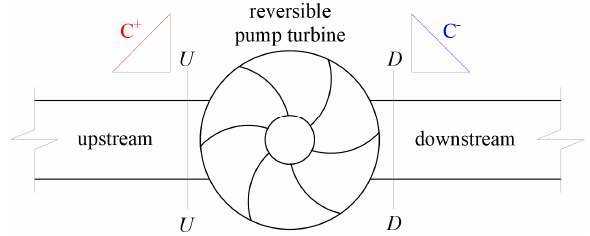
Figure 4. Sketch of reversible pump turbines (RPT) in pipeline.